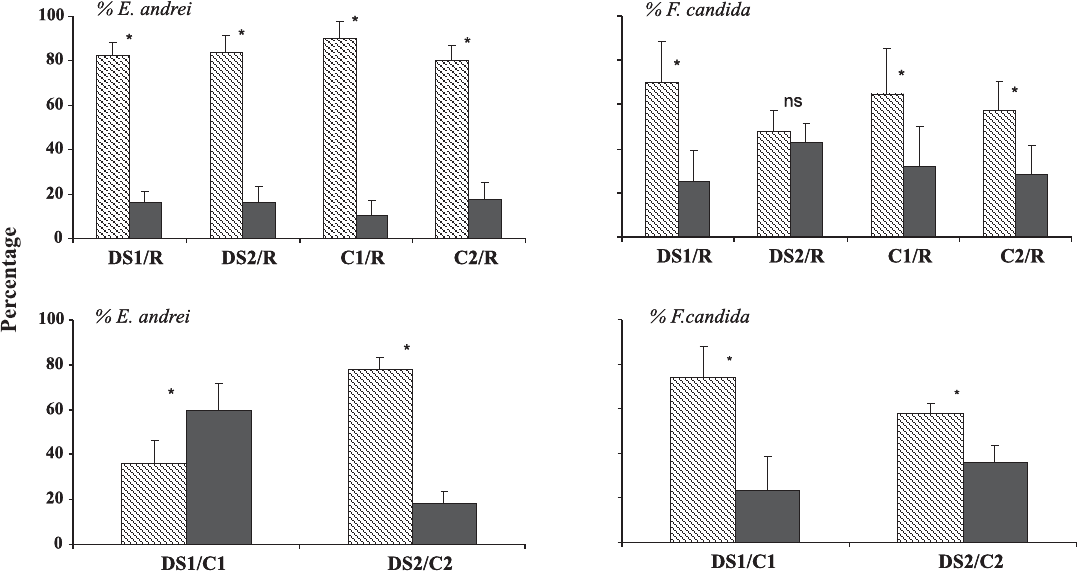
Figure 1. Avoidance response of earthworms ( Eisenia andrei ) and springtails ( Folsomia candida ) in different tested soils. C1 and C2: fields treated with conventional fertilization. DS1, DS2: Fields treated with sludge as of May 2004 (DS1), May 2005 (DS2). R: reference soil. Values are the average percentage of organisms found on control or tested sides. Vertical lines represent standard deviation. *: significantly higher percentage of organisms on the control side than on the tested side (p <